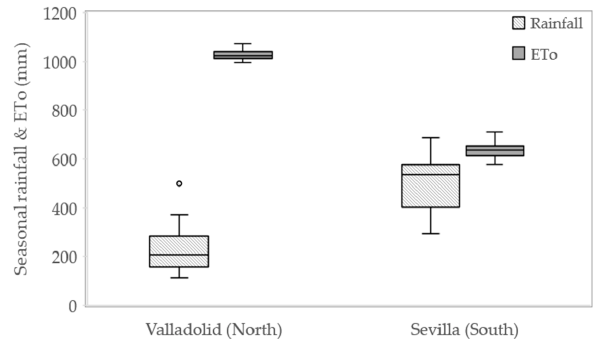
Figure 5. Cumulative rainfall and reference evapotranspiration (ETo) for the sugar beet growing cycle in Valladolid (North productive area) and Sevilla (South productive area), and for the 30 simulated seasons. The box represents 50% of the data, where the box’s upper boundary represents the upper quartile (Q3) of the data, the lower boundary represents the lower quartile (Q1) and the line inside the box represents the median (Q2). The whiskers show the largest and smallest values. The circle denotes outlier values.